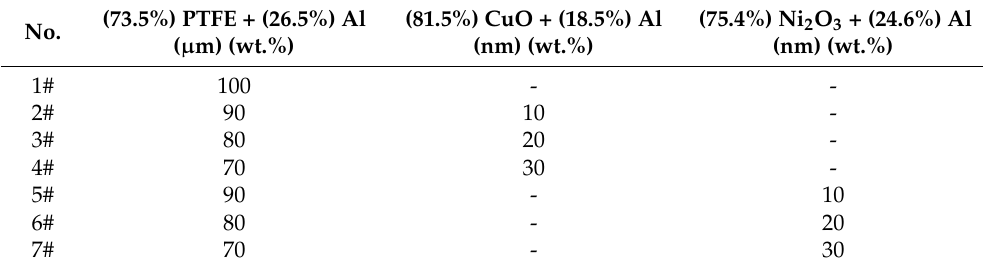
Table 1. Material number and ratio.